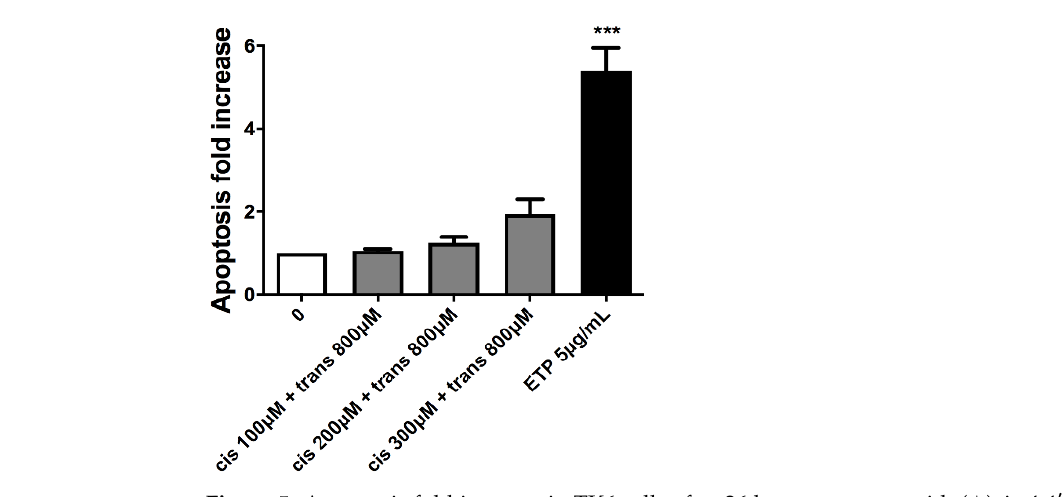
Figure 6. MNi fold increase in TK6 cells after 26 h treatment with (±)cis- 4,4′ -DMAR, (±)trans- 4,4′ - DMAR, their associations or positive controls (MMC, VINB) at the indicated concentrations com- pared to the concurrent negative control [0 µM] ( A ). Each bar represents the mean ± SEM of three independent experiments. Data were analysed using one-way repeated measures ANOVA fol- lowed by Dunnet as post-test. * p < 0.05 vs. [0 µM]; ** p < 0.01 vs. [0 µM]; *** p < 0.001 vs. [0 µM]. ° p